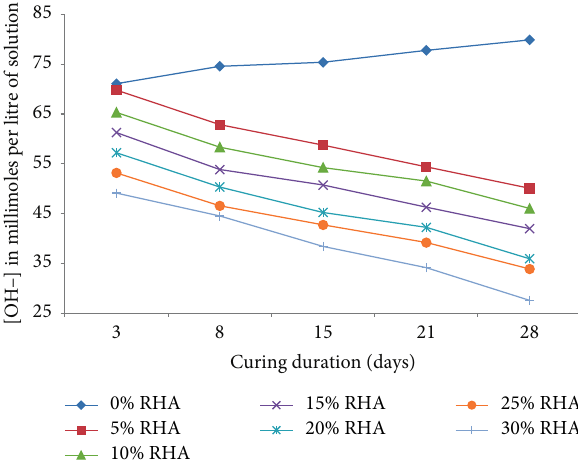
Figure 1: Concentration of OH − in RHA-PC-blended cements.